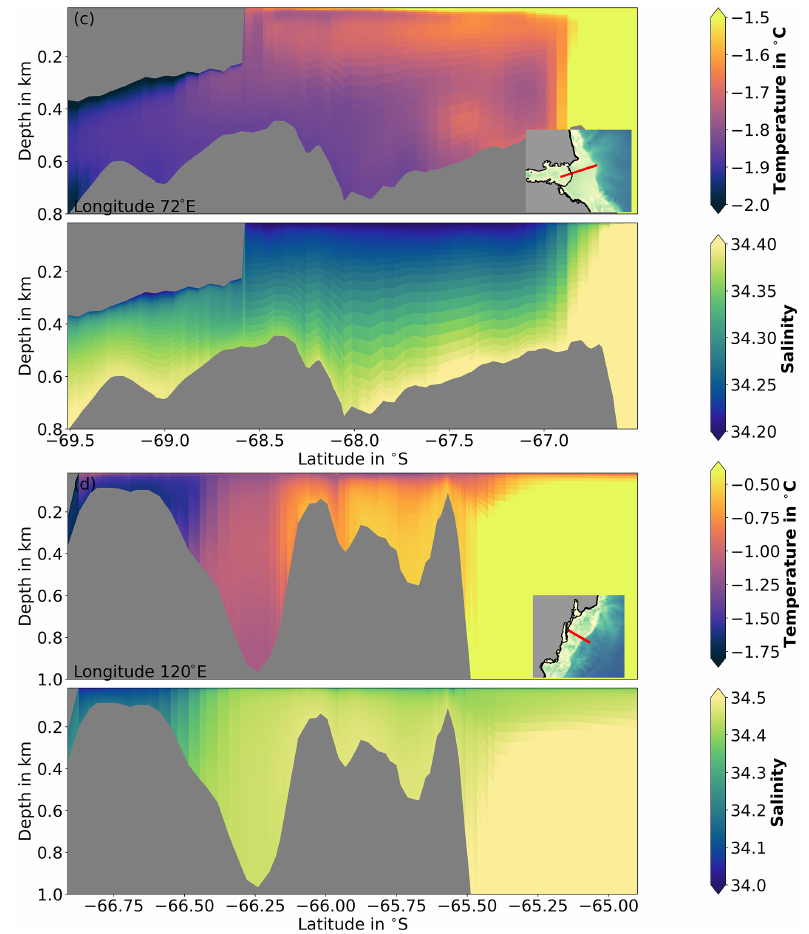
Figure 14. Temperature–salinity distribution on (a) the Weddell Sea continental shelf at 35 ◦ W, (b) the Amundsen Sea at 106 ◦ W, (c) the Prydz Bay at 72 ◦ E, and (d) the Sabrina Coast at 120 ◦ E. Insets show the transect